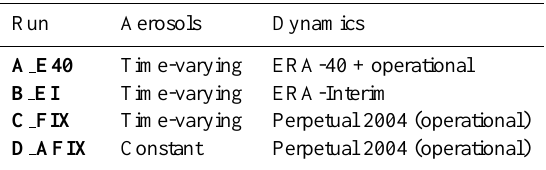
Table 1. Aerosol and dynamical conditions for the model simula- tions. All the runs use time-varying solar fluxes Run Aerosols Dynamics A E40 Time-varying ERA-40 + operational B EI Time-varying